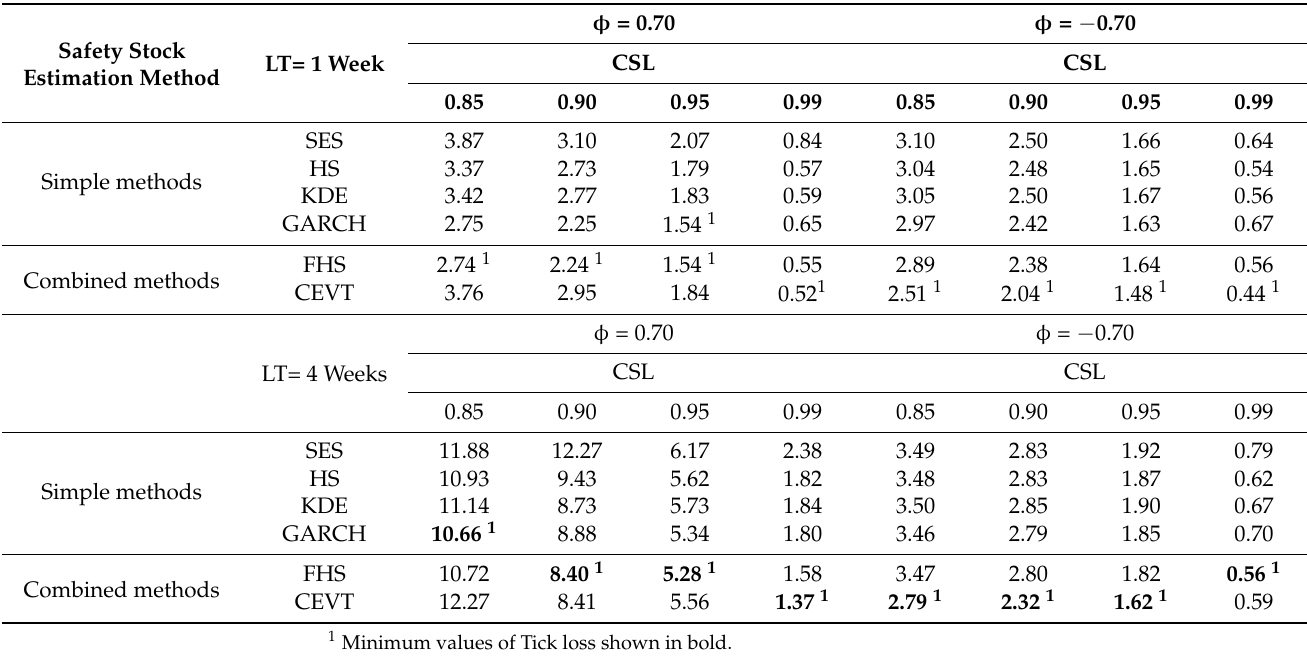
Table 3. Tick loss values corresponding to φ = 0.70 and φ = − 0.70 when forecasting errors follow a gamma distribution.